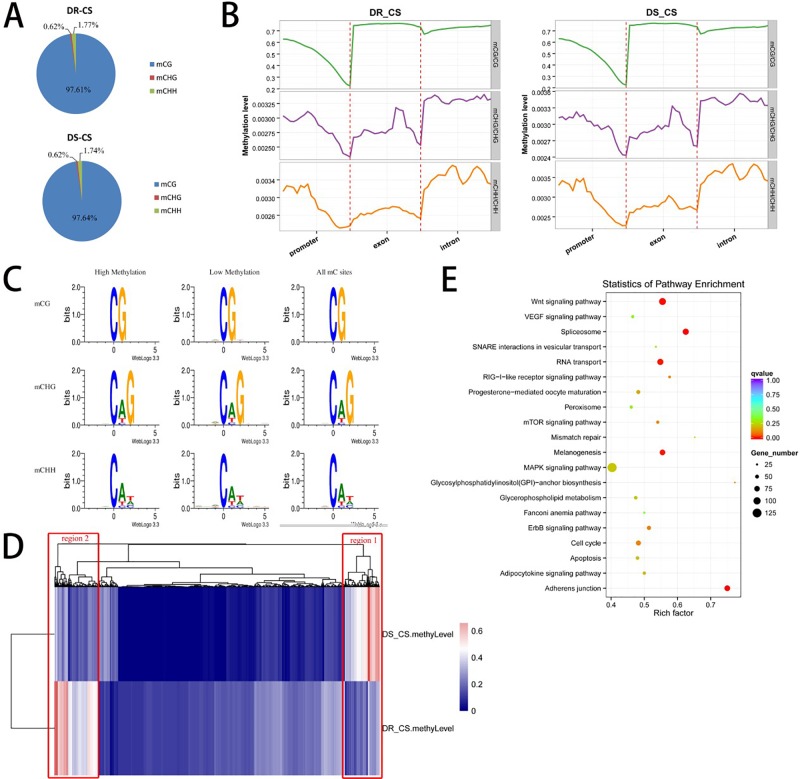
DNA methylation of the DR-CS and DS-CS families. (A) Percentage of mCs in the mCG, mCHG, and mCHH contexts. (B) DNA methylation levels in functional regions of the genome. The gene features include the promoter (the 2 kb region upstream of the transcription start site [TSS]), exons, and introns. The ordinate indicates the methylation level. (C) mCG, mCHG, and mCHH sequence motifs. The abscissa indicates the base positions. Bits indicate the occurrence of nucleotides. Four different colors represent the bases. (D) Cluster analysis of differentially methylated regions (DMRs) using a heat map. Red represents hypermethylation, and blue represents hypomethylation. The two regions with significant differences are marked in red boxes. (E) KEGG analysis of nonredundant DMR-associated genes. The x axis is the rich factor, and the y axis is the KEGG pathway classification.